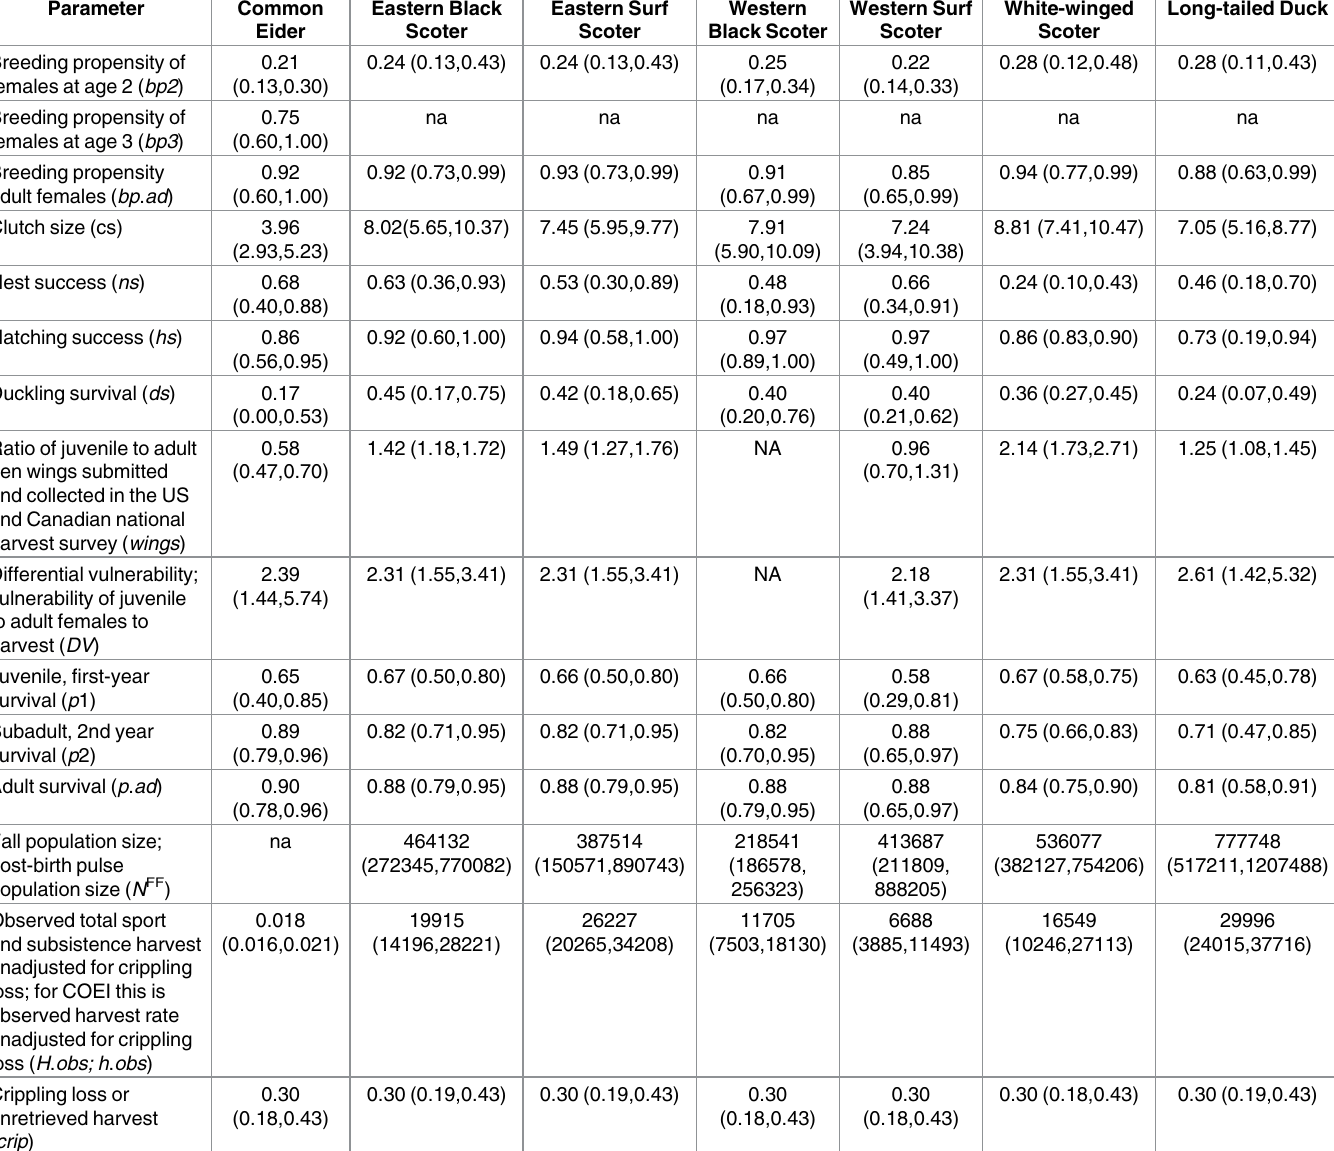
Table 1. Median and 95% credible intervals of final probability distributions for parameters used in the harvestpotential assessmentof seven sea duck populations, based on available empirical data and expert